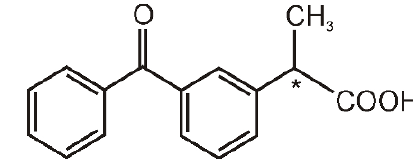
Figure 1. The structure of ketoprofen. The chiral centre is marked by the